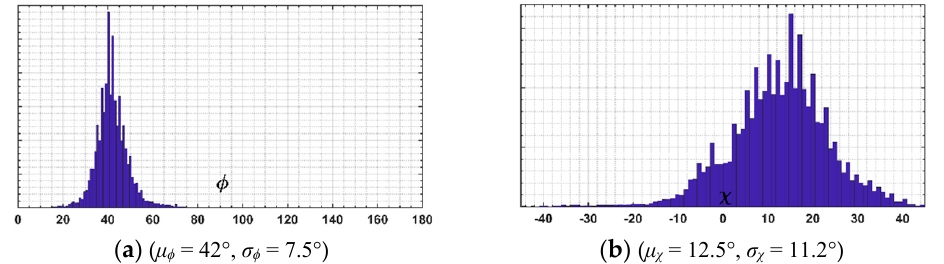
Figure 9. Histograms of the most robust polarizations, extracted from the first cavity: ( a ) Orientation angle and ( b ) ellipticity.